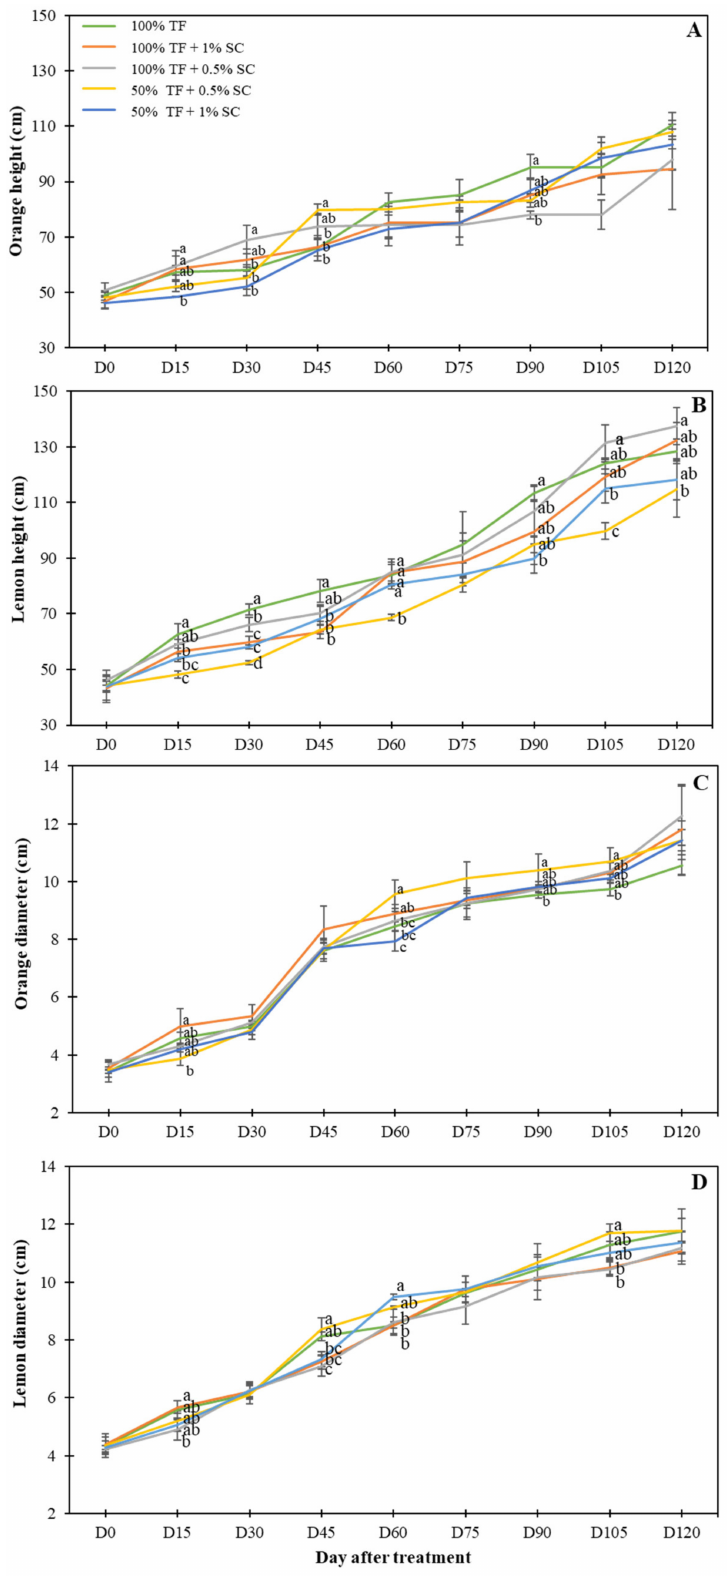
Figure 2. Height ( A , B ) and diameter ( C , D ) of orange ( A , C ) and lemon ( B , D ) seedlings grew in the presence of 100% or 50% TF fertilizer and / or 0.5 or 1% SC for 120 days (D120). Means labeled by di ff erent letters are significantly di ff erent by Tukey’s post-hoc test ( p < 0.05). Error bars represent the standard deviation ( n =